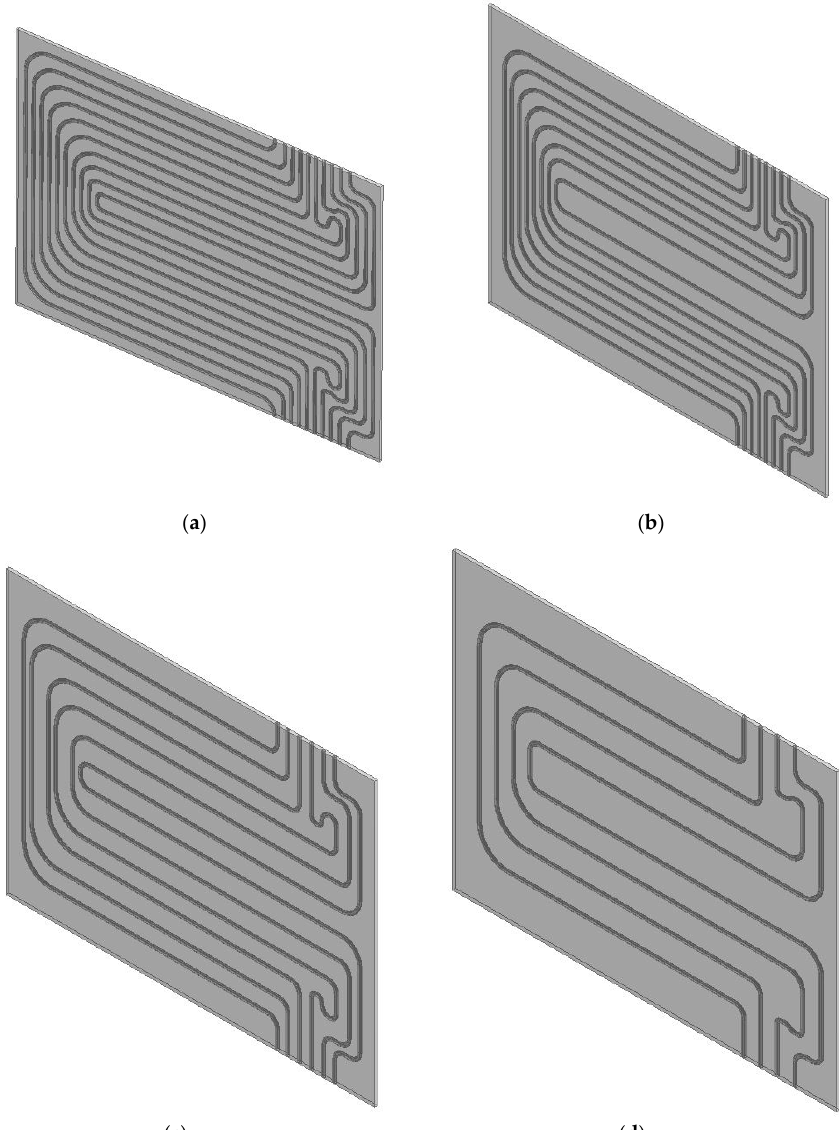
Figure 2. Cold plates with the different number cooling channels for 20 Ah lithium-ion pouch cell ( a ) 10; ( b ) 8; ( c ) 6; ( d ) 4. Table 1. Geometry details.